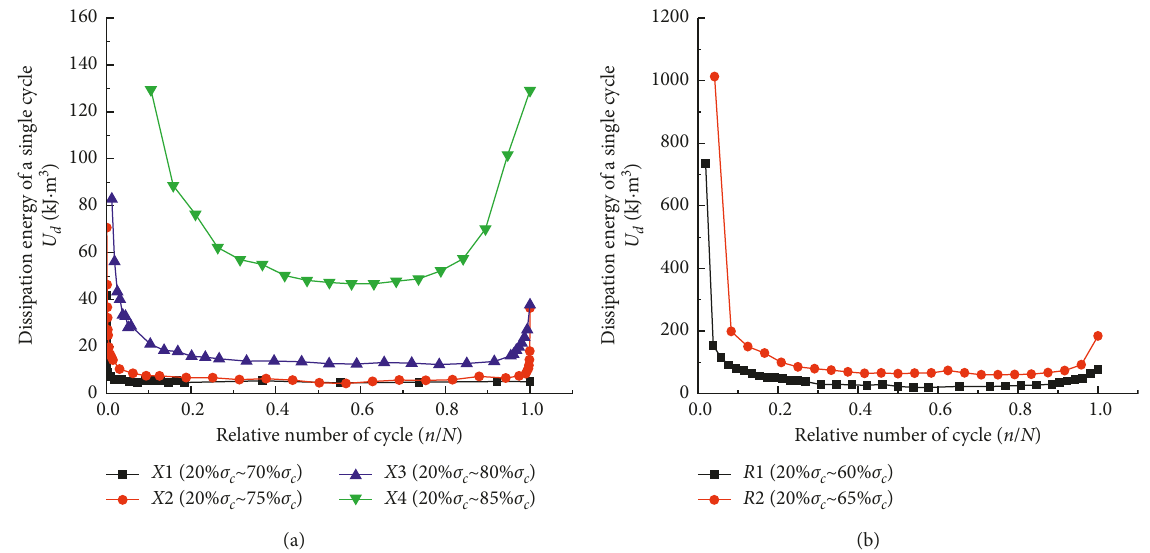
Figure 7: Dissipation energy of rock salt under different maximum stress. (a) Cyclic loading test and (b) cyclic creep